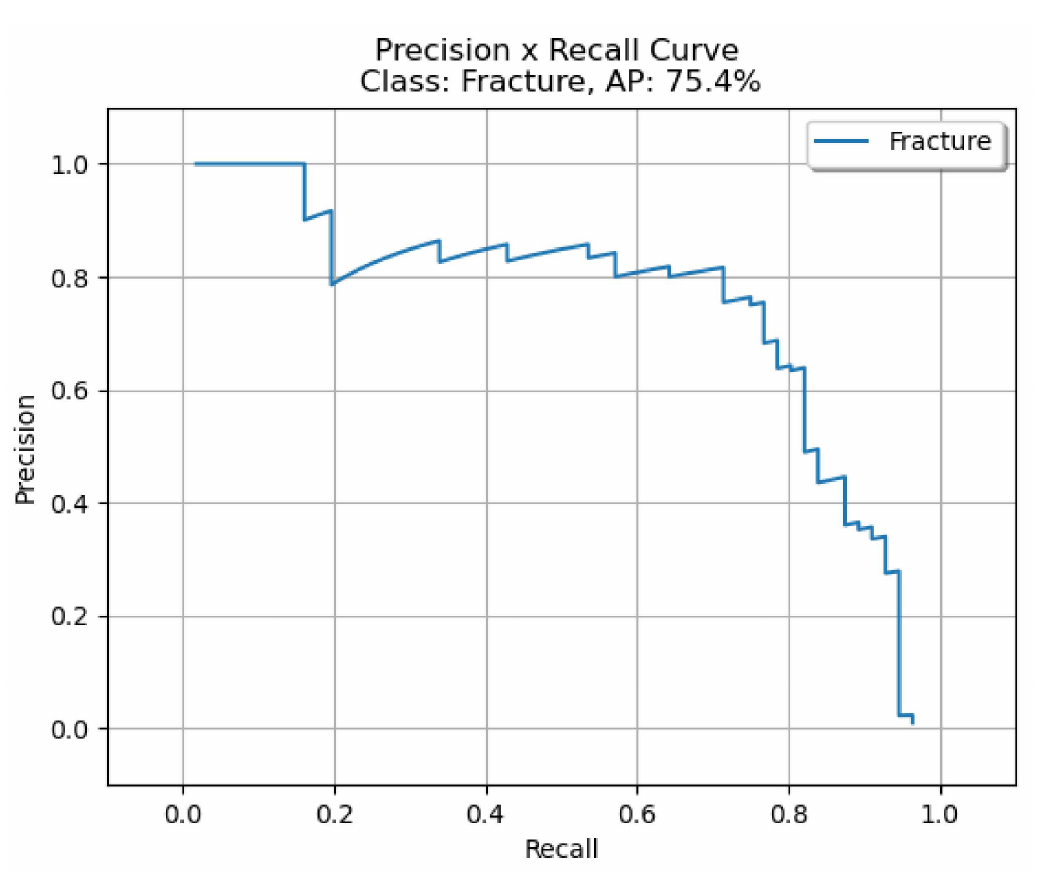
Figure 18. Precision-recall curve of PAA (best score of 20 models).